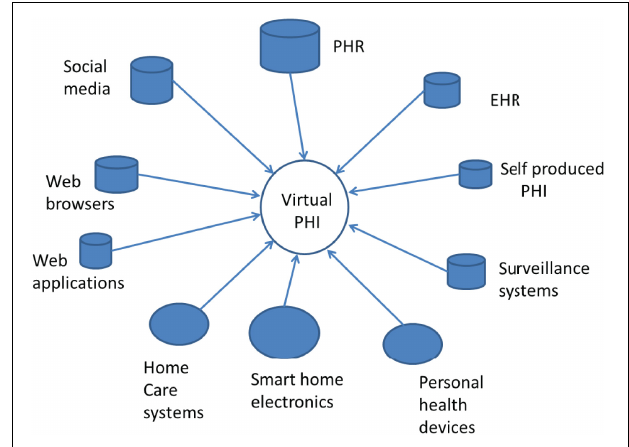
FIGURE 1 | Typical sources of the personal health information